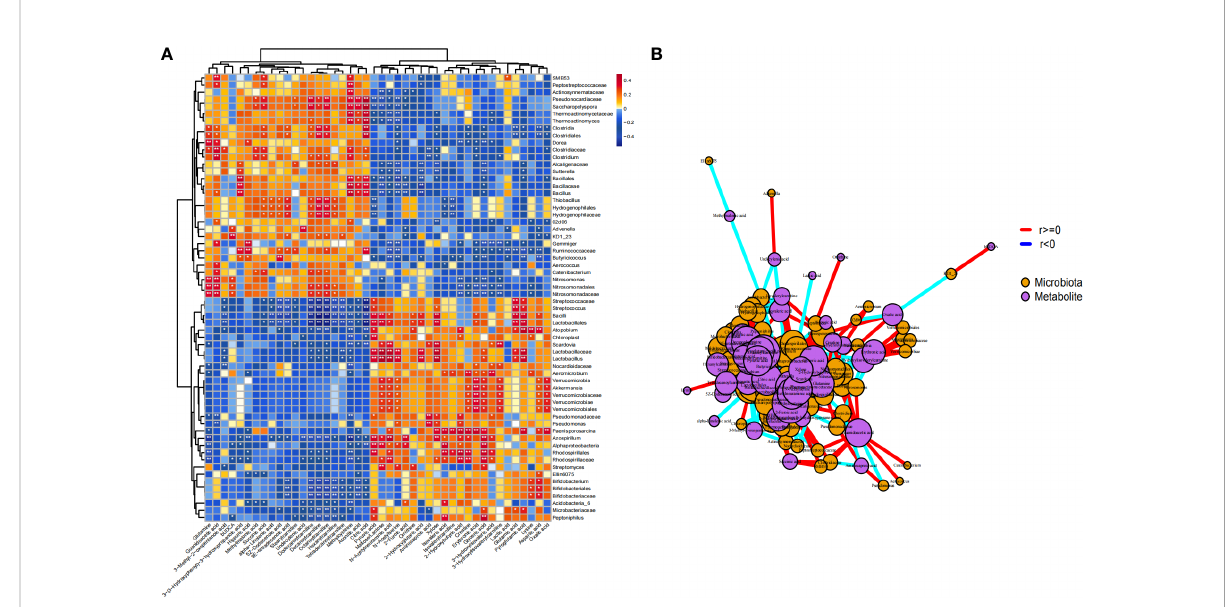
FIGURE 6 Comprehensive correlation network analysis of microbiota and metabolites in serum. (A) Heat map showing the Spearman correlation between different microbiota and different metabolites in stool samples (P < 0.05); (B) Network diagram. Purple nodes represent the metabolites of fecal samples, orange nodes represent microbiota. The size of nodes and the number of inter-node connections are linearly related. * p<0.05 **